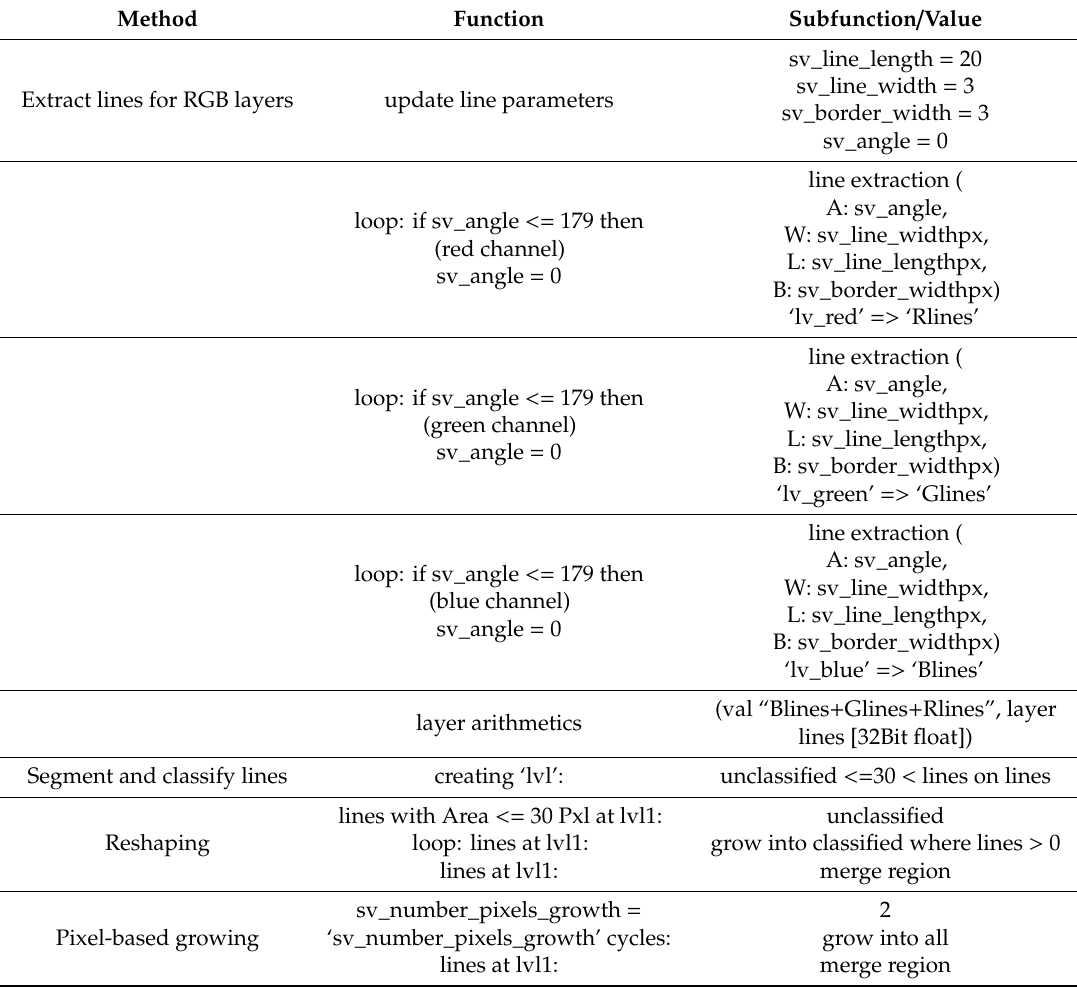
Table 5. The eCognition processing parameters used for raster data-based dead wood mapping. Method Function Subfunction / Value